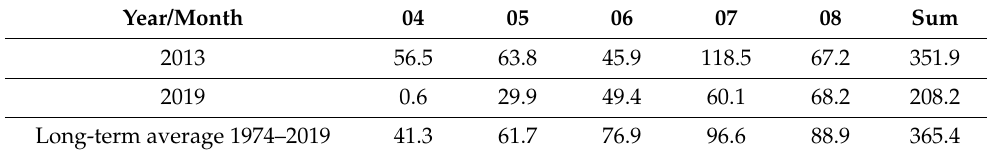
Table 5. Precipitation (mm) during the growing season in 2013 and 2019, Kaunas Meteorological